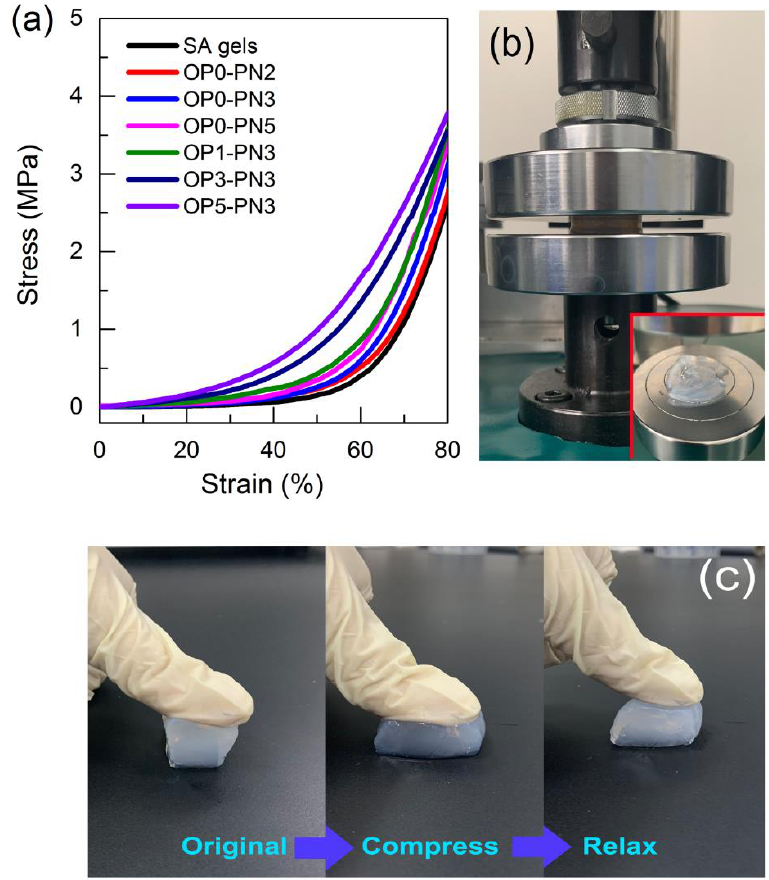
Figure 3. Compression properties of OPn-PNm gels: ( a ) stress–strain curves of sodium alginate (SA) and OPn–PNm gels under compression tests; ( b ) OP3-PN3 gels under 95% strain compression; ( c ) compression and resilience behavior of OP3-PN3 gels.